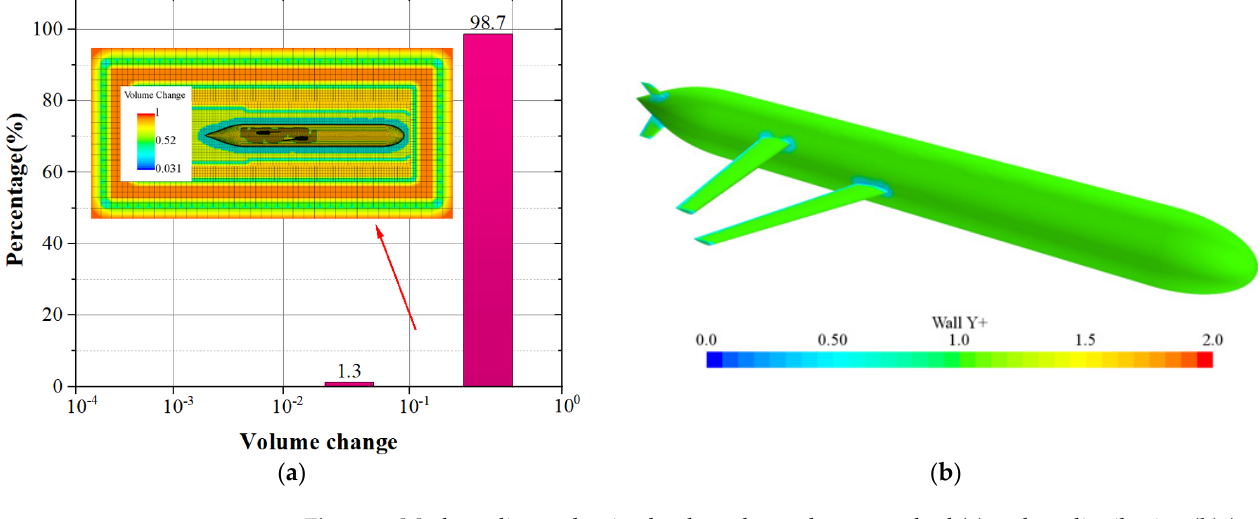
Figure 6. Mesh quality evaluation by the volume change method ( a ) and y+ distribution ( b ) (mesh base size 0.25 m).